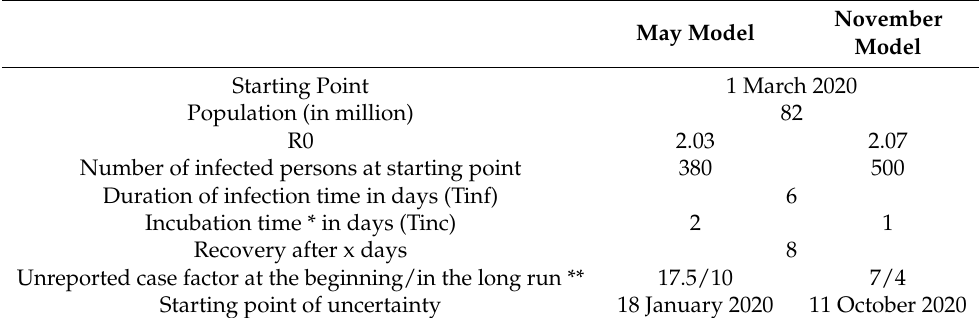
Table A1. Basic parameters of the